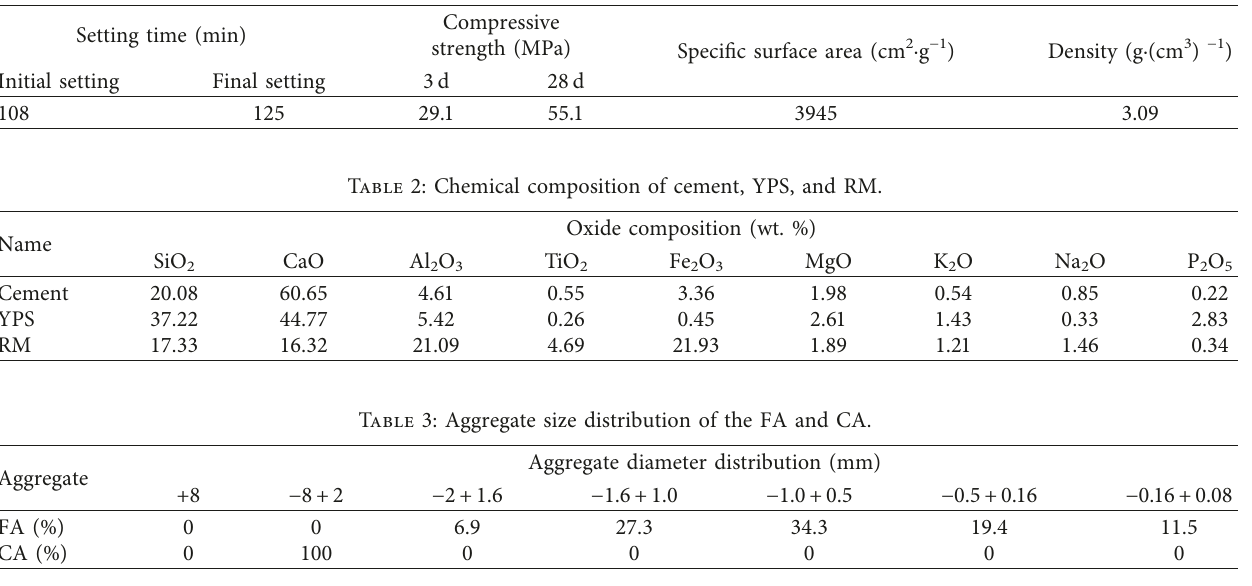
Figure 1: Particle size distribution of the RM and YPS. Table 1: Physical properties of cement.